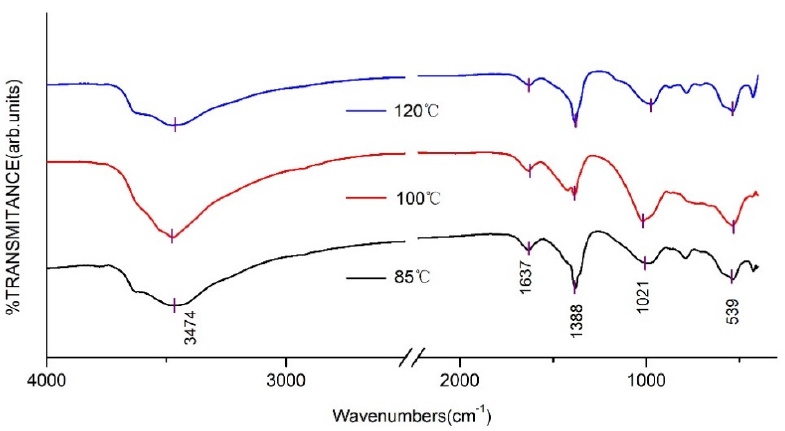
Figure 3. FT-IR spectrum of CaAl–SiO 3 –LDHs prepared at different crystallisation temperatures.